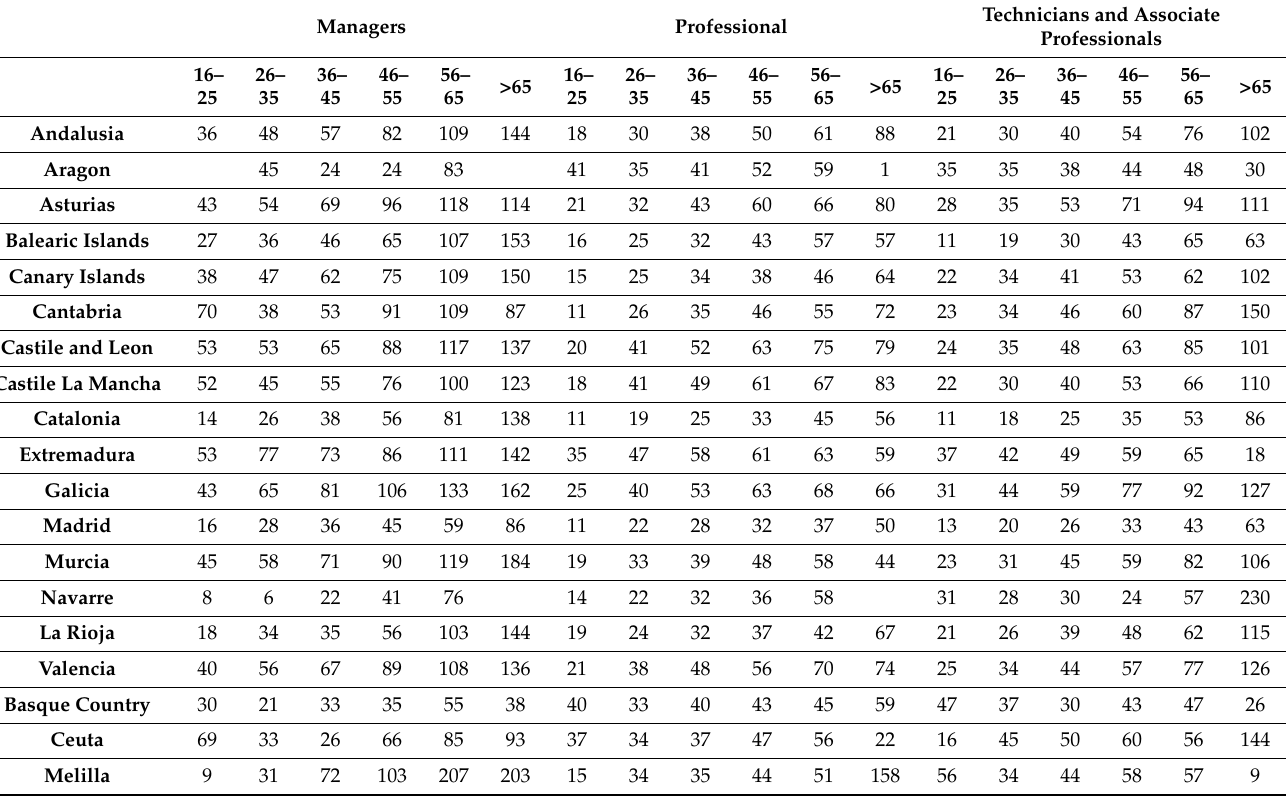
Table 3. Average duration of sickness absence by aged ranges and ISCO-08